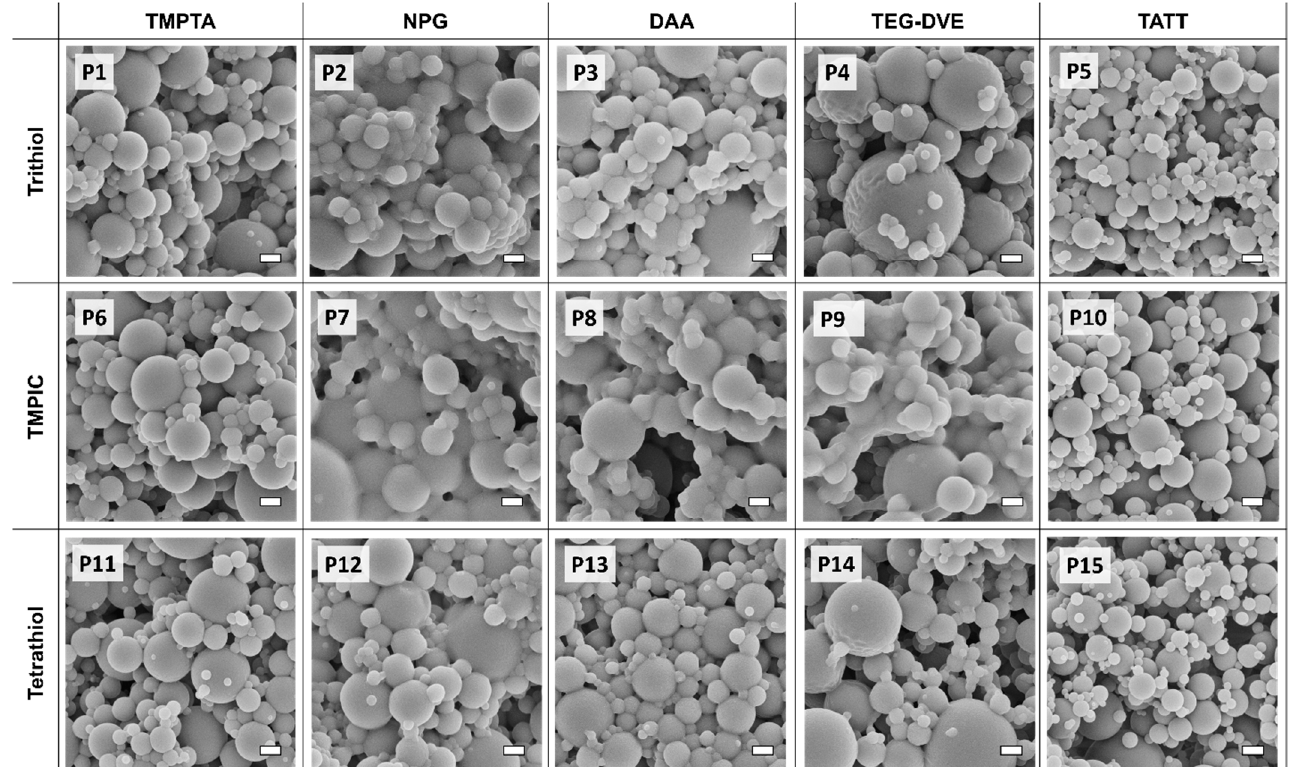
Figure 3. SEM images of polymer nanoparticles produced via aerosol photopolymerization from various thiol-ene monomer combinations. For simplicity, the nomenclature of thiol and alkene monomers is presented on the left-hand side and the top, respectively. The scalebar corresponds to 1 µm. The nomenclature agrees with the formulations listed in Table 1.